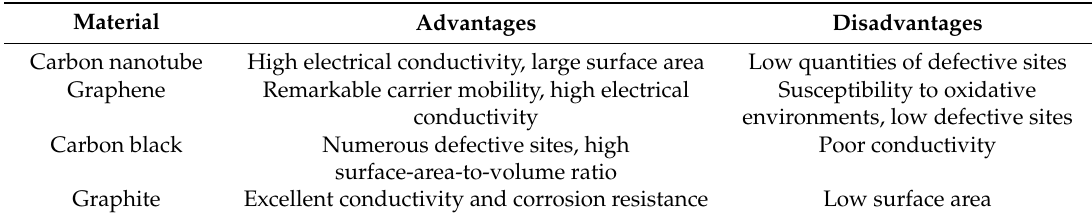
Table 2. Properties of various carbon-based materials. Reproduced with permission from Reference [18], Elsevier